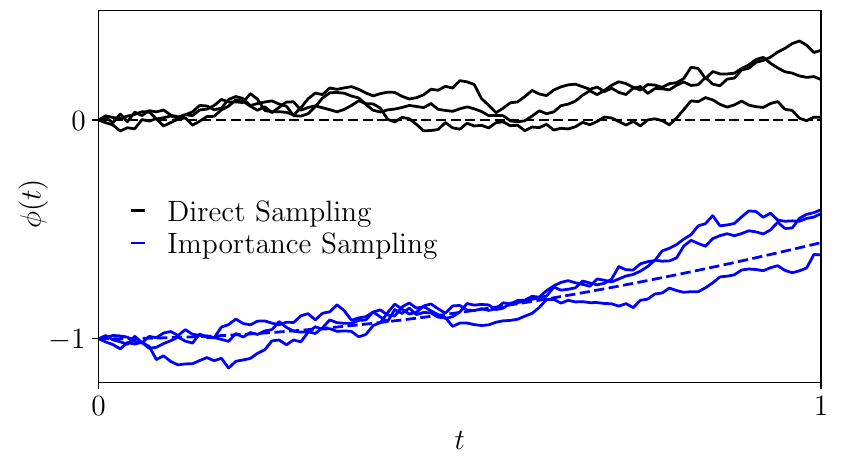
Figure 1: Illustration of the importance sampling approach. When directly sampling according to the measure (5), one predominantly generates trajectories around φ = 0 (dashed black line), which might however carry a small contribution to a given ob- servable. In contrast, in the importance sampling approach one preferentially gener- ates trajectories in the vicinity of the saddle point trajectory (dashed blue line), which carries the largest contribution. The solid black and blue lines respectively represent stochastic trajectories generated according to direct and importance